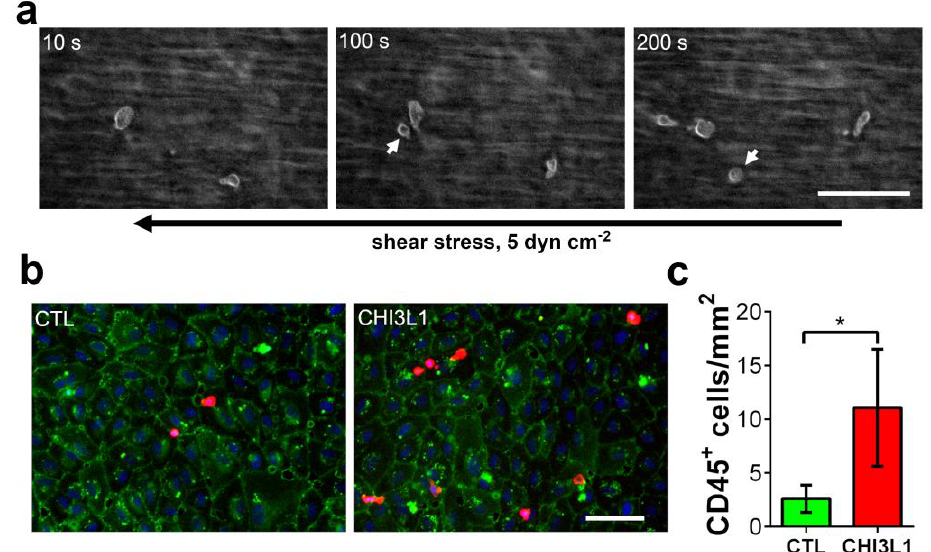
Figure 6. Microfluidic experiments indicate that CHI3L1 is able to promote adhesion of immune cells to endothelial cells. ( a ) HUVECs were perfused for 30 min with whole hirudin blood at a shear stress of 5 dyn cm − 2 . Shown are snapshots taken during the experiments by reflection interference contrast microscopy at indicated time points (10 s, 100 s and 200 s). The corresponding video is shown in Video S1. The black arrow indicates the flow direction. White arrows indicate leukocytes recruited from the flowing blood. Scale bar = 50 µ m ( b ) Representative immune fluorescence images of the HUVEC layers after the flow experiment. HUVECs were stimulated with BLM cell supernatants, harvested from BLM cells either treated with 400 ng/mL CHI3L1 or PBS (CTL). CD31 was used as an endothelial cell marker (green); CD45 was used as an immune cell marker (red). Nuclei were stained with 4′,6-diamidino-2-phenylindole (DAPI, blue). Scale bar = 100 µm ( c ) Quantitative evaluation of immune cell adhesion. n = 5; * = p ≤ 0.05 Student’s t -test.